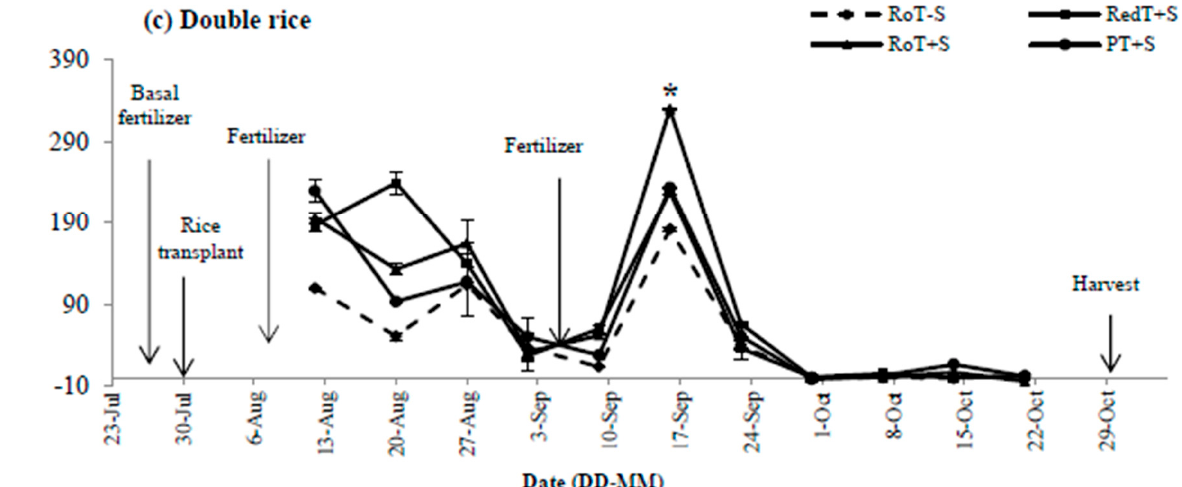
Figure 2. Impacts of straw incorporated tillage patterns on CH 4 fluxes in the three rice cropping systems. PT − S indicates plough tillage + no straw, RoT − S indicates rotary tillage + no straw, RedT + S indicates reduced tillage + straw, RoT + S indicates rotary tillage + straw; PT + S indicates plough tillage + straw. Since the baseline of soil tillage was different, PT − S and RoT − S were respectively implemented as the control in different test sites. * indicates a significant difference at 0.05 probability level in each cropping system.